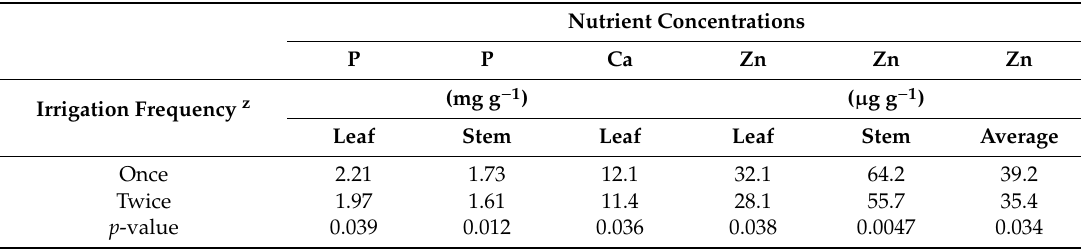
Table 3. Irrigation frequency affects nutrient concentrations in leaves, stems, or averaged in the plant of H. macrophylla ‘Merritt’s Supreme’.